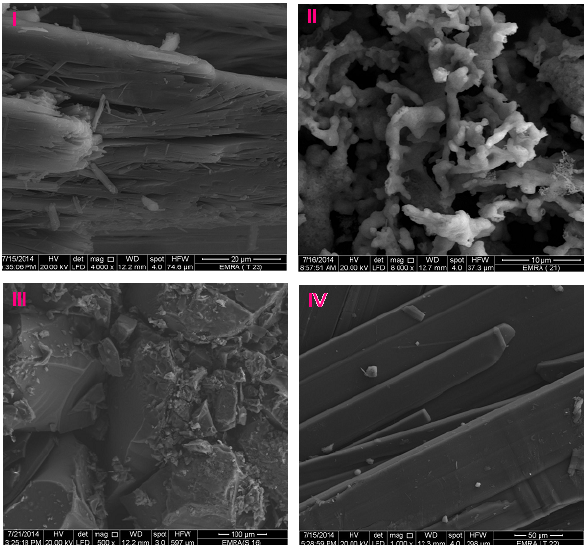
Figure 4. The SEM images of ( I ) Mn(II), ( II ) Cu(II), ( III ) Co(II), and ( IV ) Ni(II)–Gpn.